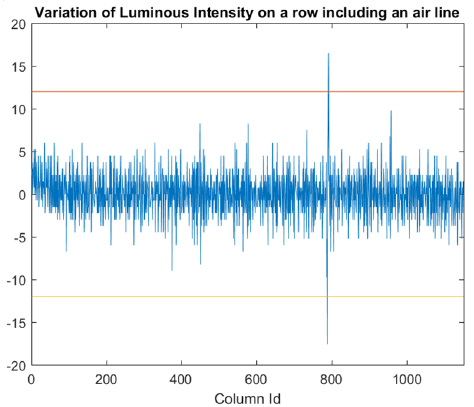
Figure 8. A frame with an air line defect. Row a is a row including the air line.